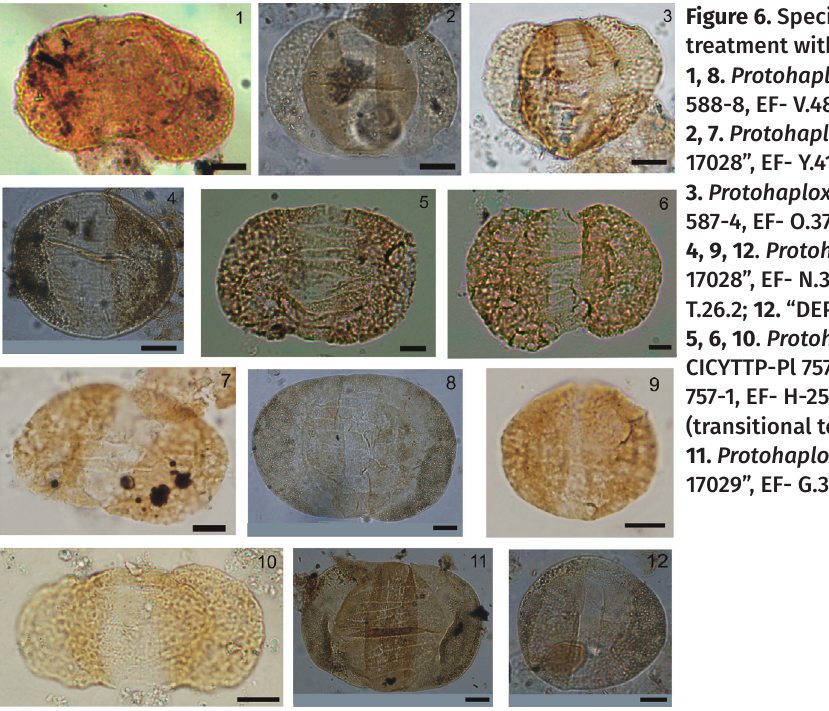
Figure 6. Specimens from Brazil after the treatment with HCl and HF. Scale bar= 15